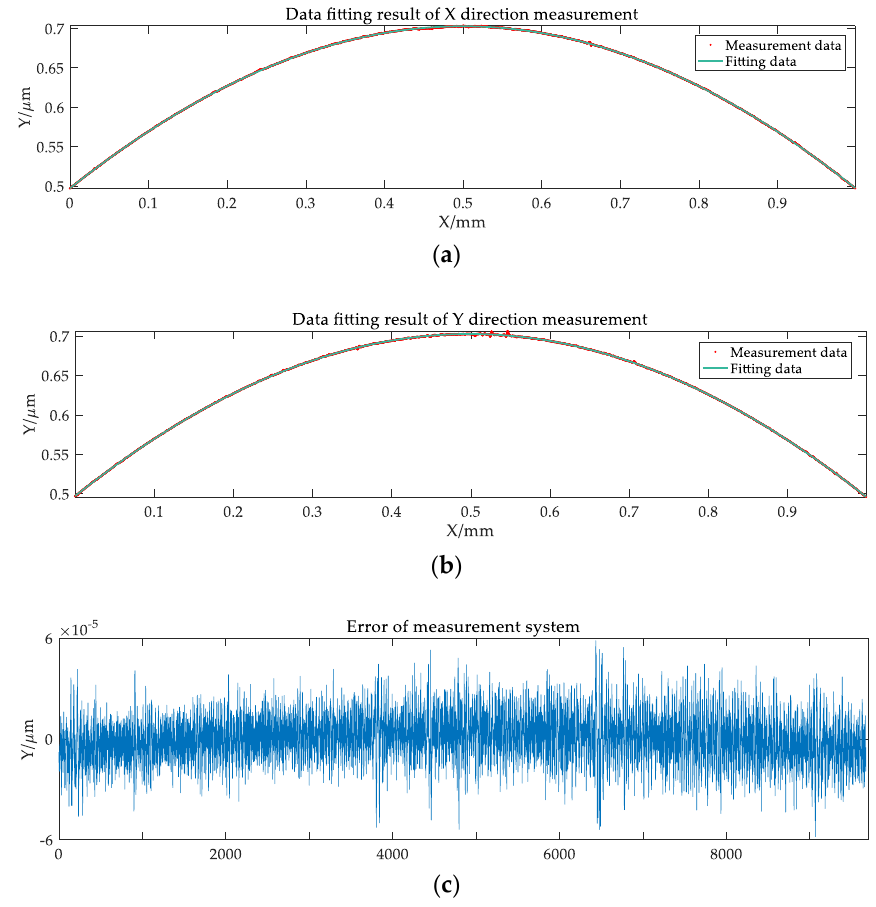
Figure 12. Pre-debugging of the experimental system. ( a ) Data fitting results of X direction measurement; ( b ) data fitting results of Y direction measurement; ( c ) analysis of the measurement error to verify the measurement accuracy of the system.